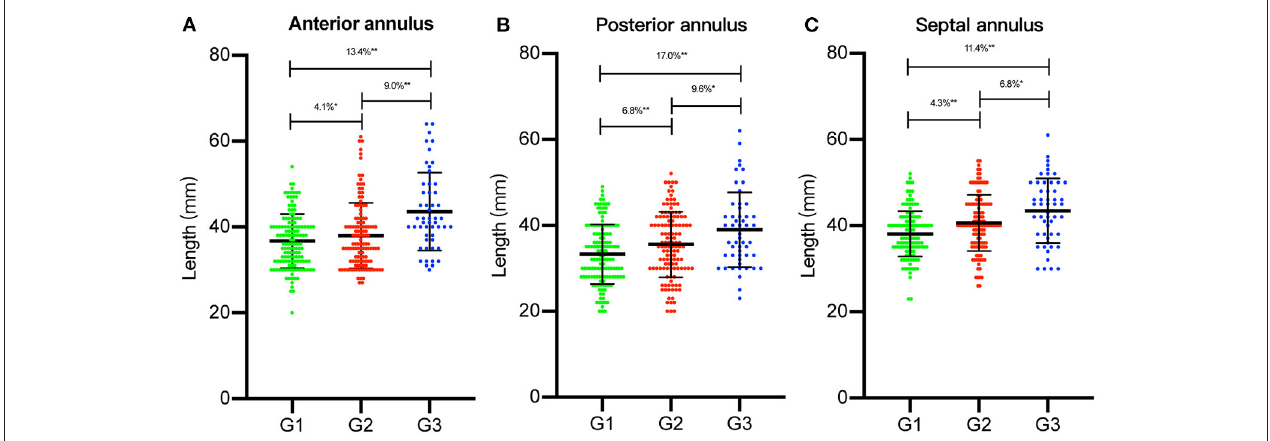
FIGURE 1 | The length of each segment of tricuspid annulus (TA) was measured intraoperatively. Each segment of TA [ (A) anterior annulus; (B) posterior annulus; (C) septal annulus] was compared between three groups [group 1 (G1), group 2 (G2), and group 3 (G3)]. The percentage of dilation of each segment of TA was illustrated. * p < 0.05, ** p <